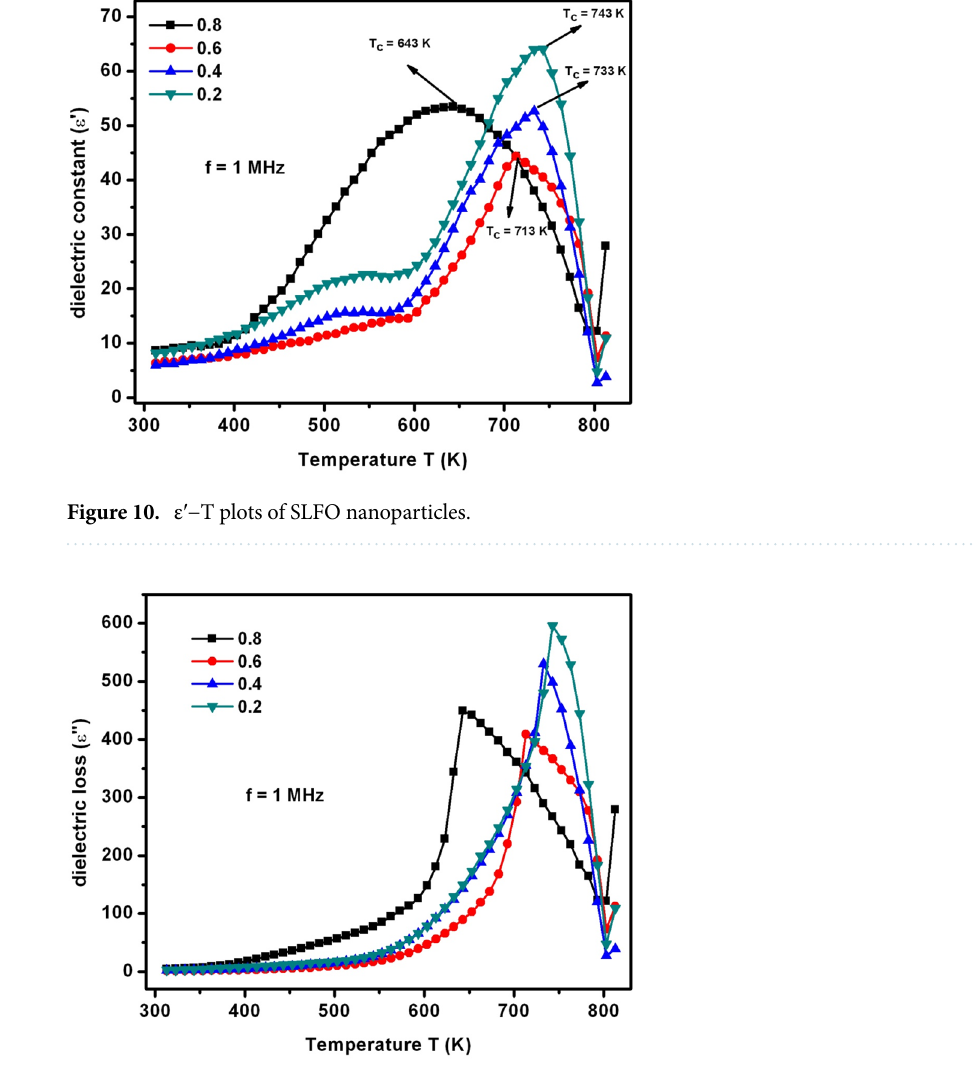
Figure 11. ε ″ −T plots of SLFO